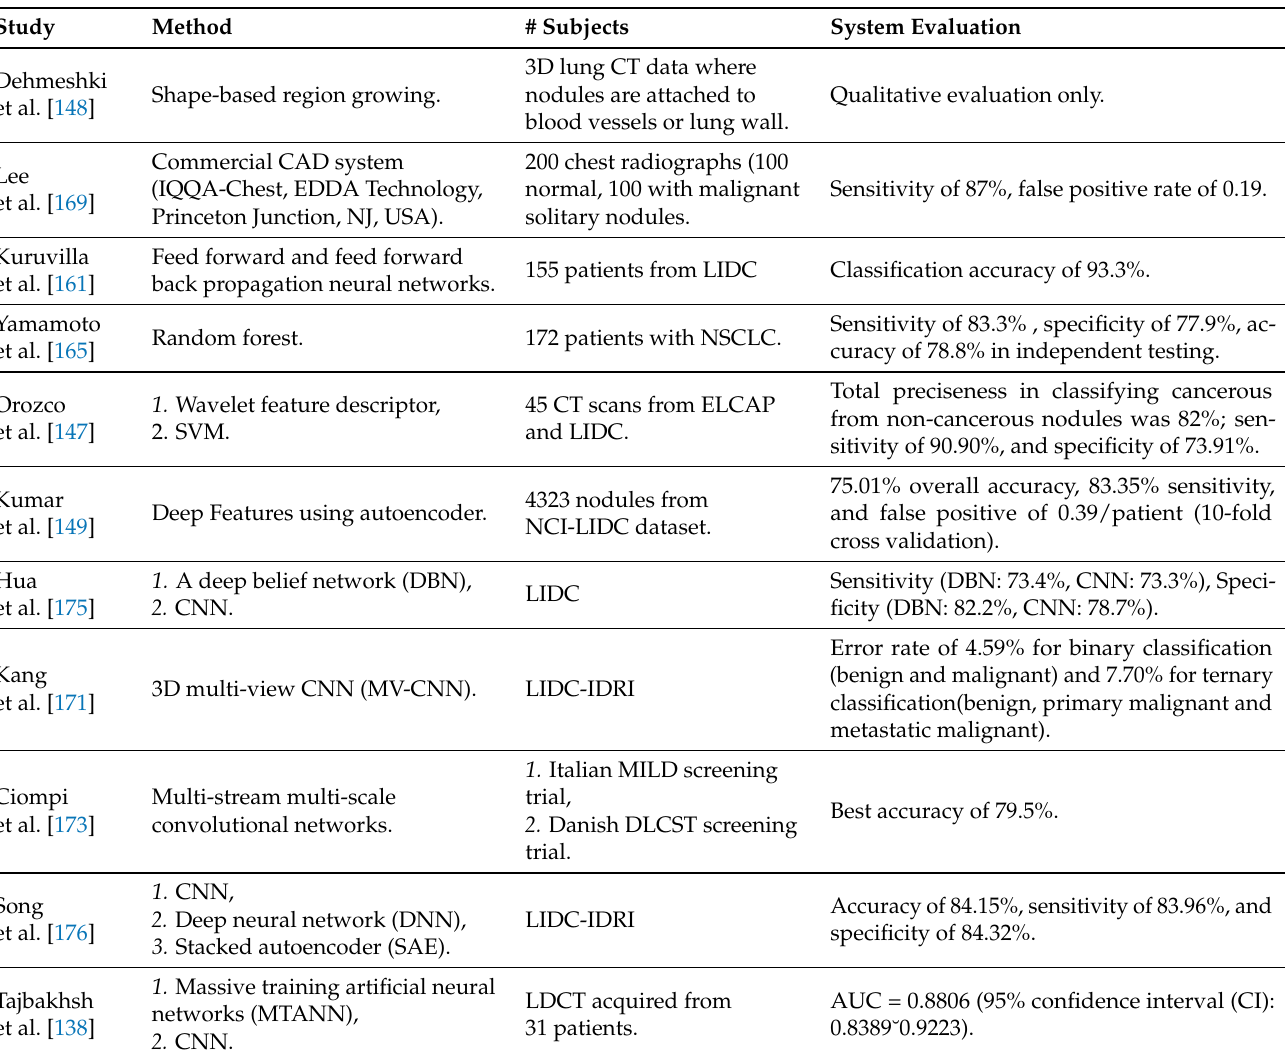
Table 3. Literature review of pulmonary nodule classification